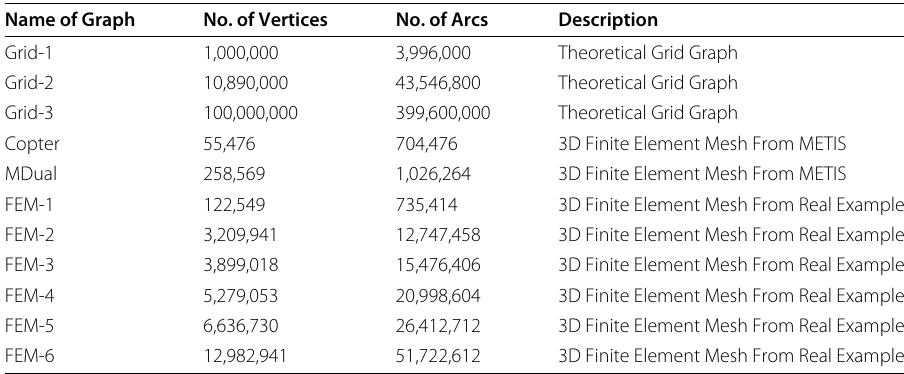
Table 1 The Characters of